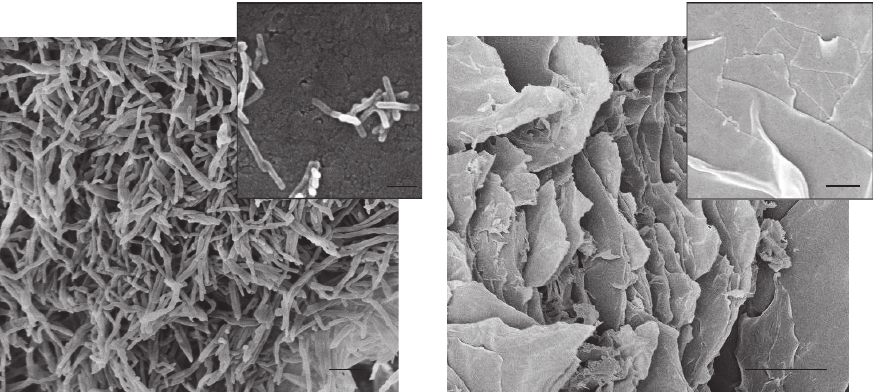
Figure 1: SEM image of nanofiber and nanosheet morphologies in bulk state. The inserted images are shown as a single nanofiber and nanosheet on a silicon wafer. The scale bars indicate 300 nm and 100nm and 10 𝜇 m and 1 𝜇